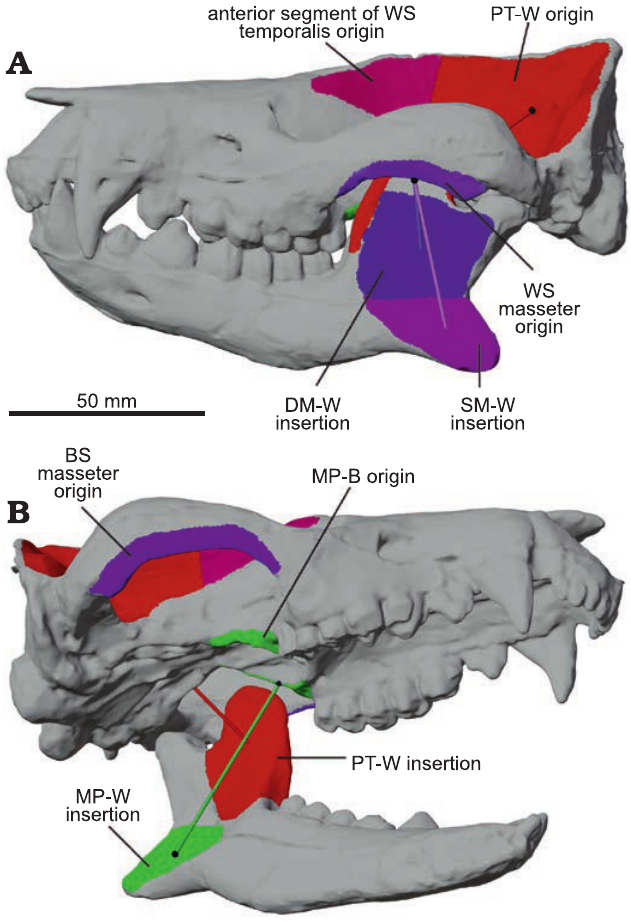
Fig. 2. Reconstructed skull and hemimandibles of meridiolestidan mammal Peligrotherium tropicalis Bonaparte, Van Valen, and Kramarz, 1993(digi- tized from models produced by Paéz-Arango 2008). A . Skull and mandibles articulated into closed gape position and showing the attachments of several major muscle groups. B . Right-inferior oblique view of lower left hemi- mandible and skull in open gape position. Here the left side of the skull is assumed to be the working-side (WS), and the right side the balancing-side (BS); see Tables 1 and 2. Colored tubes are the lines-of-action of their re- spective muscle category; matching colored surfaces represent correspond- ing estimated origin and insertion areas; and black spheres show the loca- tions of corresponding origin or insertion centroids. Abbreviations: DM-W, deep masseter working-side; MP-W/B, medial pterygoid working-side/ balancing-side; PT-W, posterior temporalis muscle category working-side; SM-W, superficial masseter